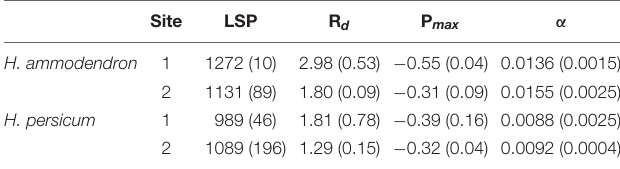
Site 1, shallow groundwater depth; Site 2, deeper groundwater depth; LSP, light saturation point ( µ mol m − 2 s − 1 ); R d , dark respiration ( µ mol m − 2 s − 1 ); P max , light-saturated CO 2 uptake ( µ mol m − 2 s − 1 ) was derived by applying a modified rectangular hyperbola model to light response data; α , initial slope. The values in parentheses represent SE (n =